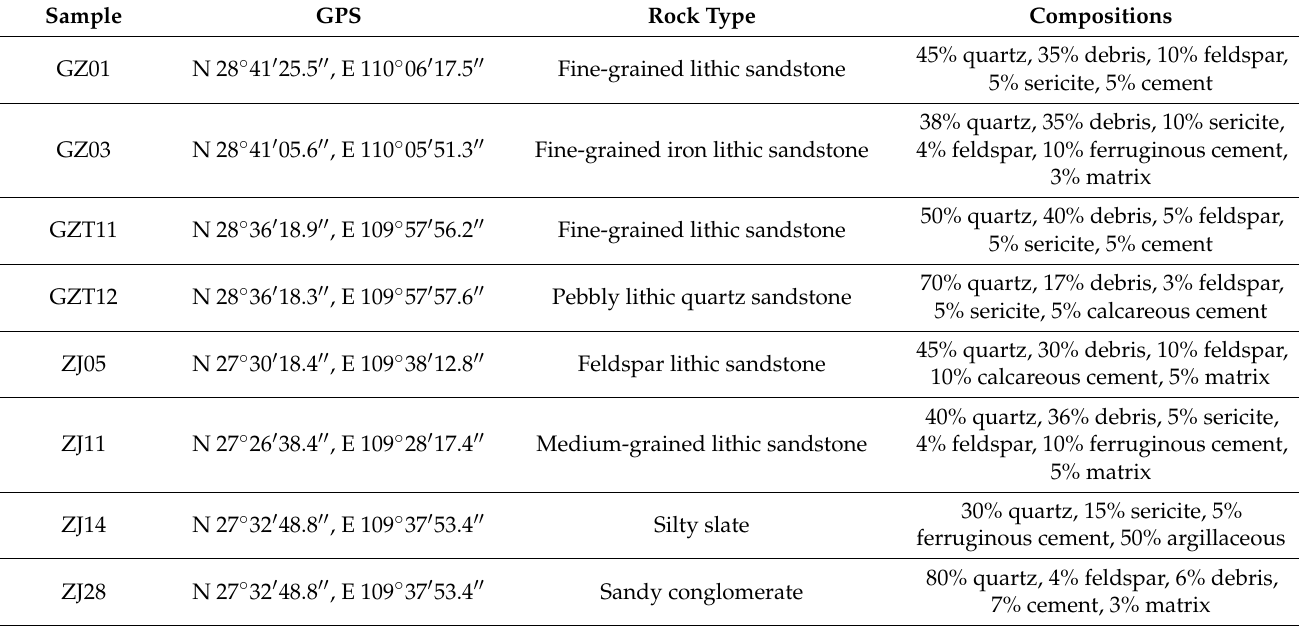
Table 1. Sampling locations and the petrological features for metasedimentary rocks from the